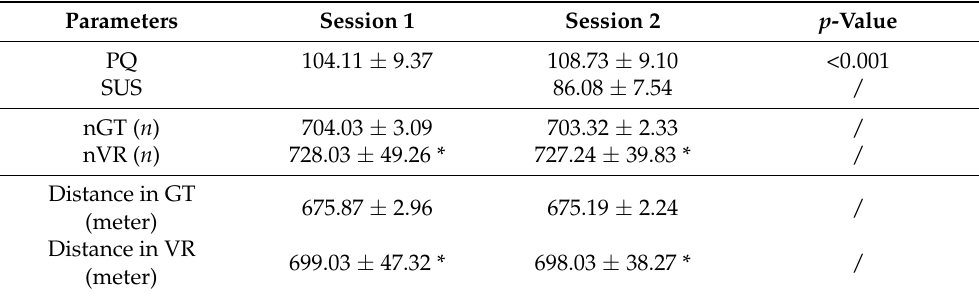
Table 2. Comparison of the mean data values during RAGT sessions in fully immersive VR. Parameters Session 1 Session